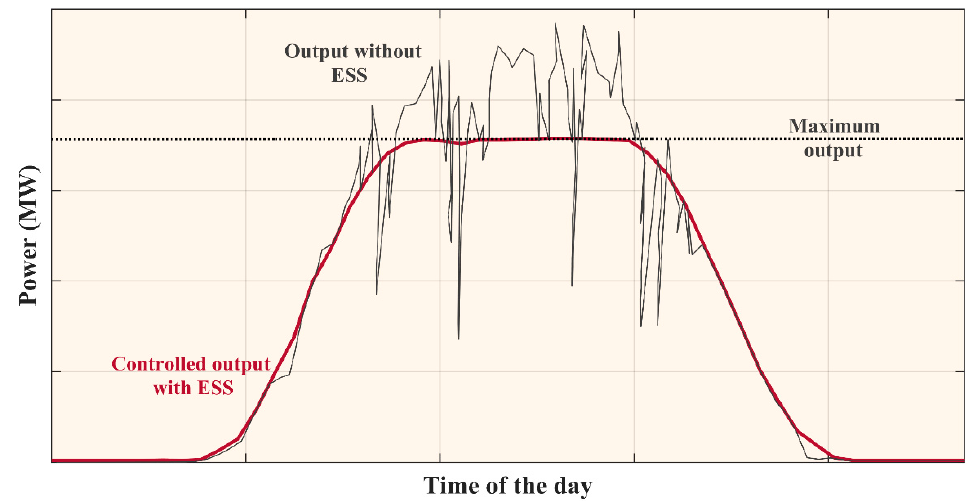
Figure 6. Power output of renewable energy sources with and without energy storage system.